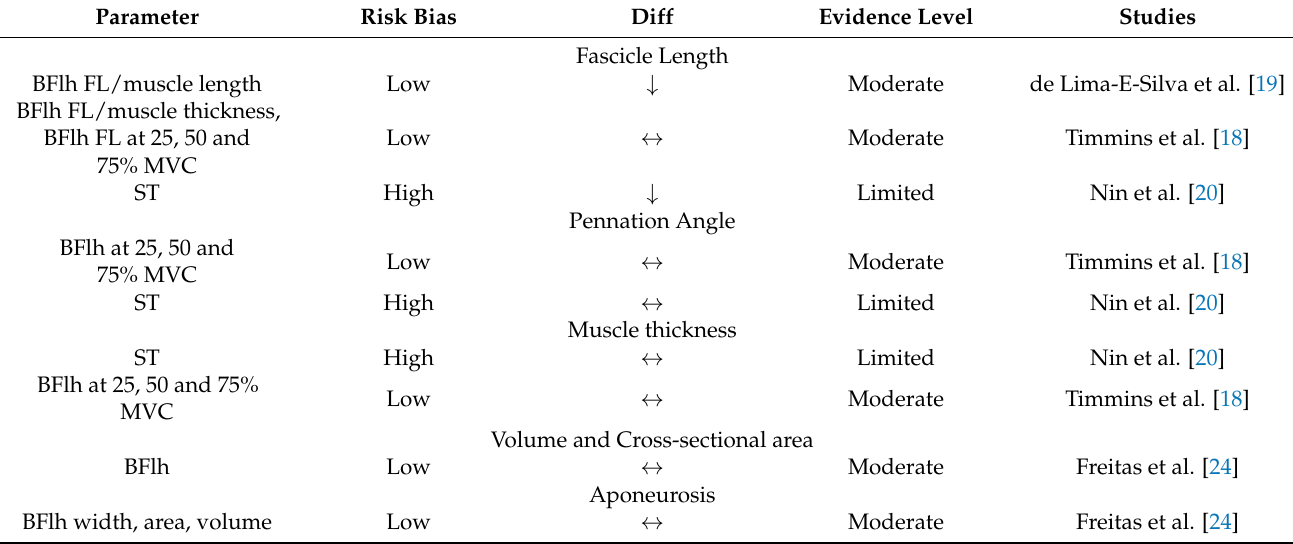
Table 4. Results of best evidence synthesis of studies that compared muscle architecture between participants with previous hamstring injury and